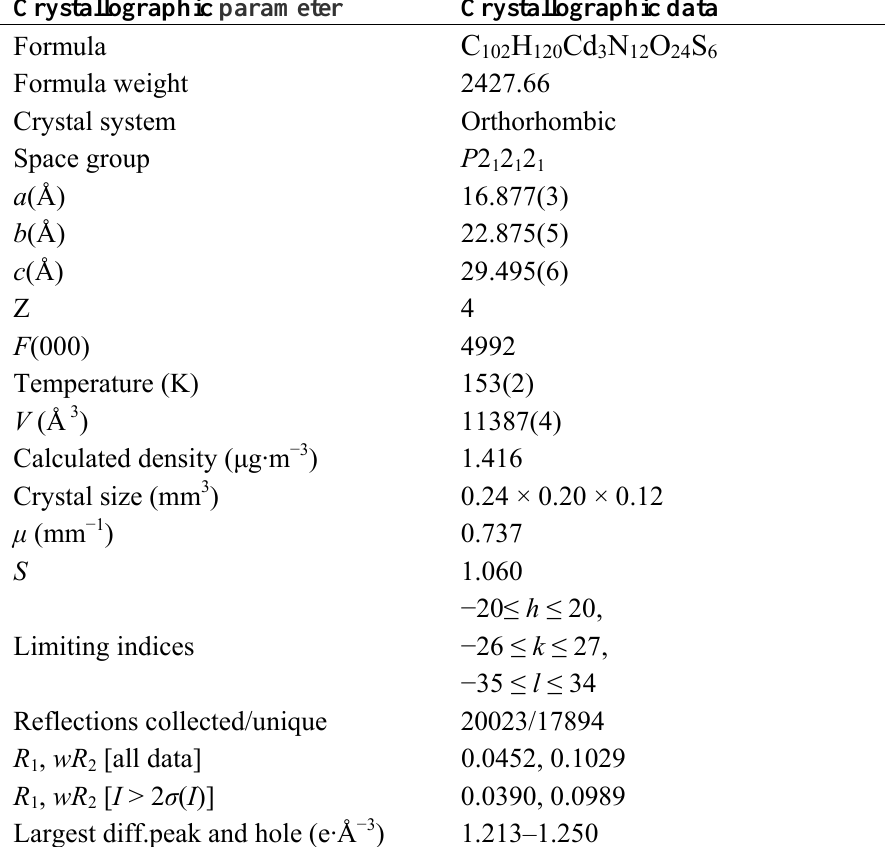
Table 1. Crystallographic data for the Cd (II)